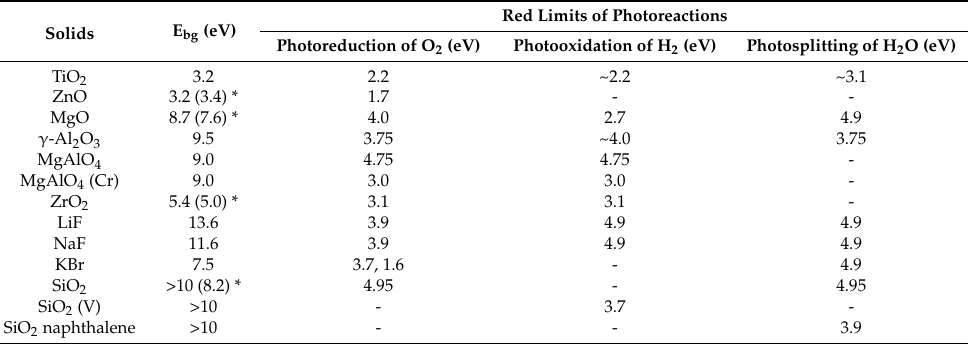
Table 2. Bandgap energies and red limits of the photoreduction of oxygen, photooxidation of hydrogen and the photosplitting of adsorbed water. Taken in part from Refs. [32,44]. Red Limits of Solids E bg (eV)